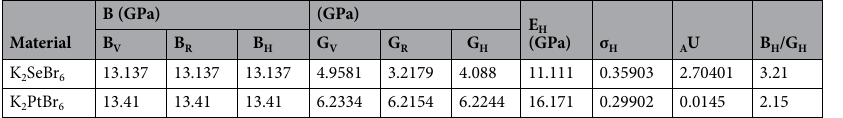
Table 3. The bulk modulus, shear modulus, Young’s modulus, Poisson’s ratio, anisotropy factorand B H /G H ratio for K 2 XBr 6 (X = Pt, Se).